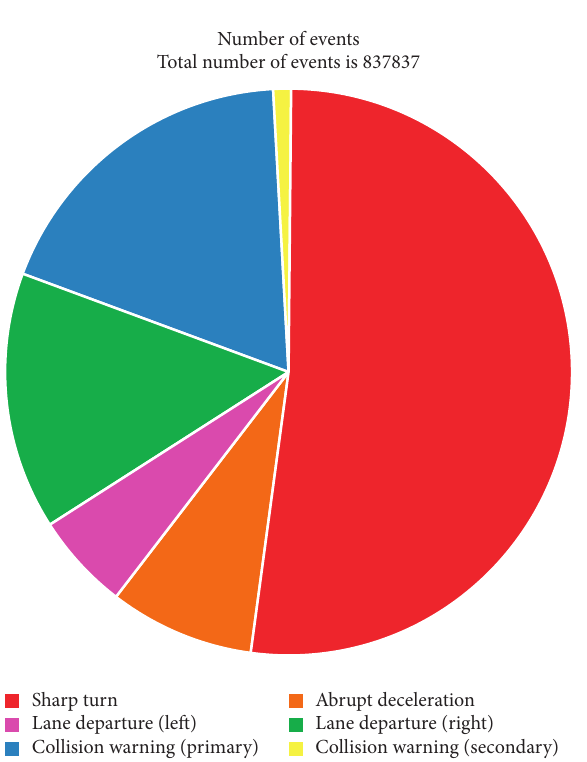
Figure 5: Statistics of number and proportion of early warning events.